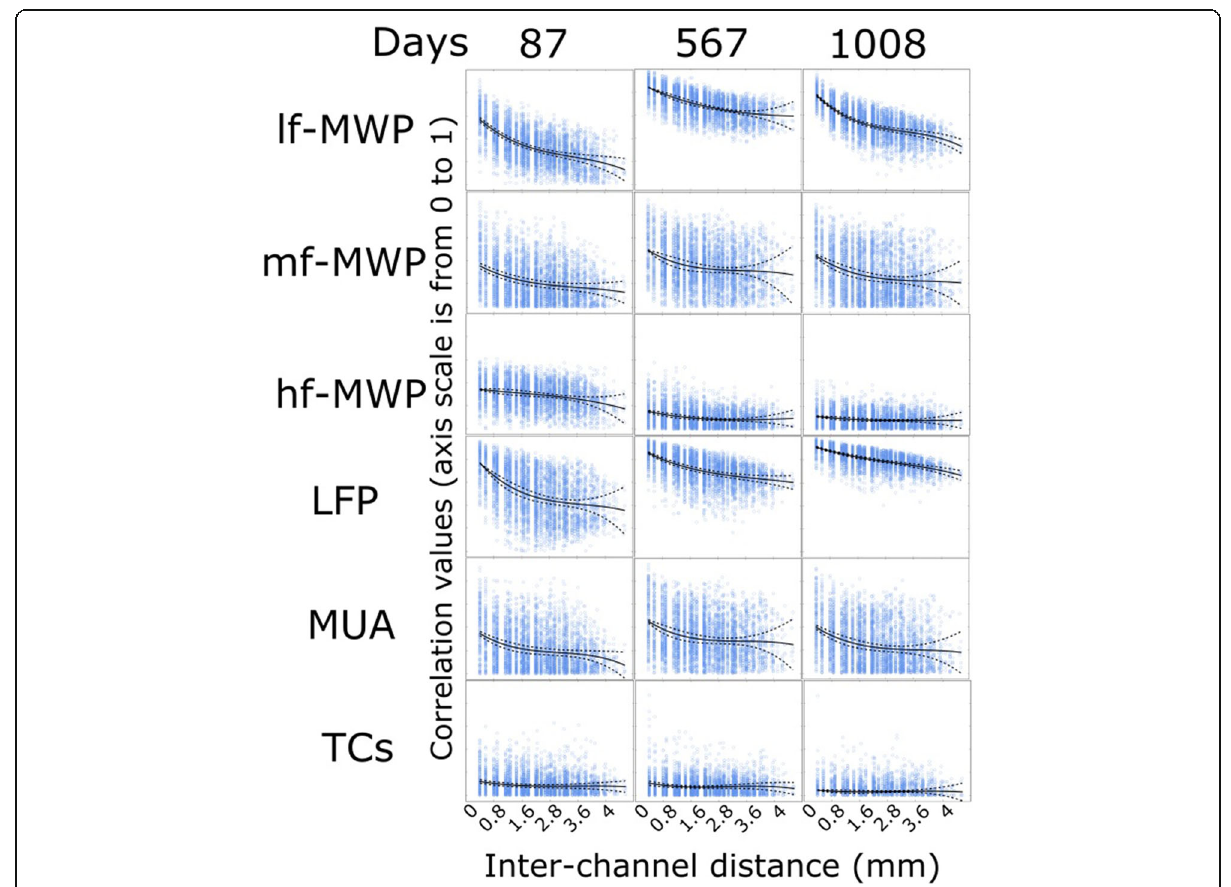
Fig. 6 Correlation values between paired channels of neural features affected by the inter-electrode distance. We selected 3 days over the course of the study from Task 2 to investigate the effect of inter-electrode distance on neural features correlations. In each insertion, y-axis shows the correlation from 0 to 1 and x-axis shows the inter-elelctrode distance in mm. A data point represents the correlation value of two selected channels for a particular type of neural features time series. The solid line represents a 3rd polynomial fit of the data and dashed lines indicate its 95% confidence interval. In general, signal correlation decreases as the inter-elelctrode distance increases. Signal with higher frequency range has lower inter-electrode correlation, and TCs features has the lowest inter-electrode correlation values overall